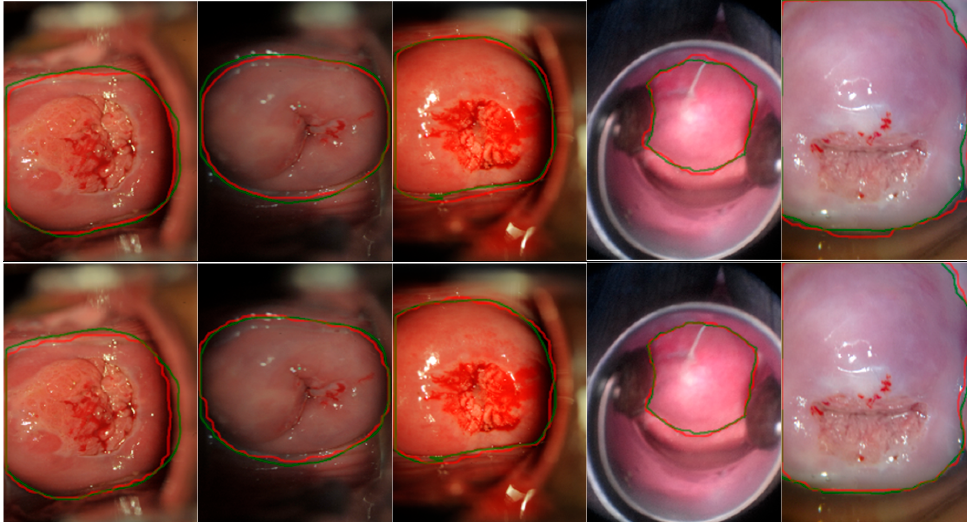
Figure 5. Visualization and Comparison of results from Mask R-CNN and Mask X R-CNN tested on datasets A and C. The 1st row images are test results from Mask X R-CNN, the 2nd row images are results from Mask R-CNN. The green lines are the ground truth marked by human experts, red lines are model predictions.